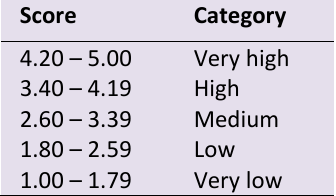
Table 2 . The Ranges of Multiple Intelligences Questionnaire and Their